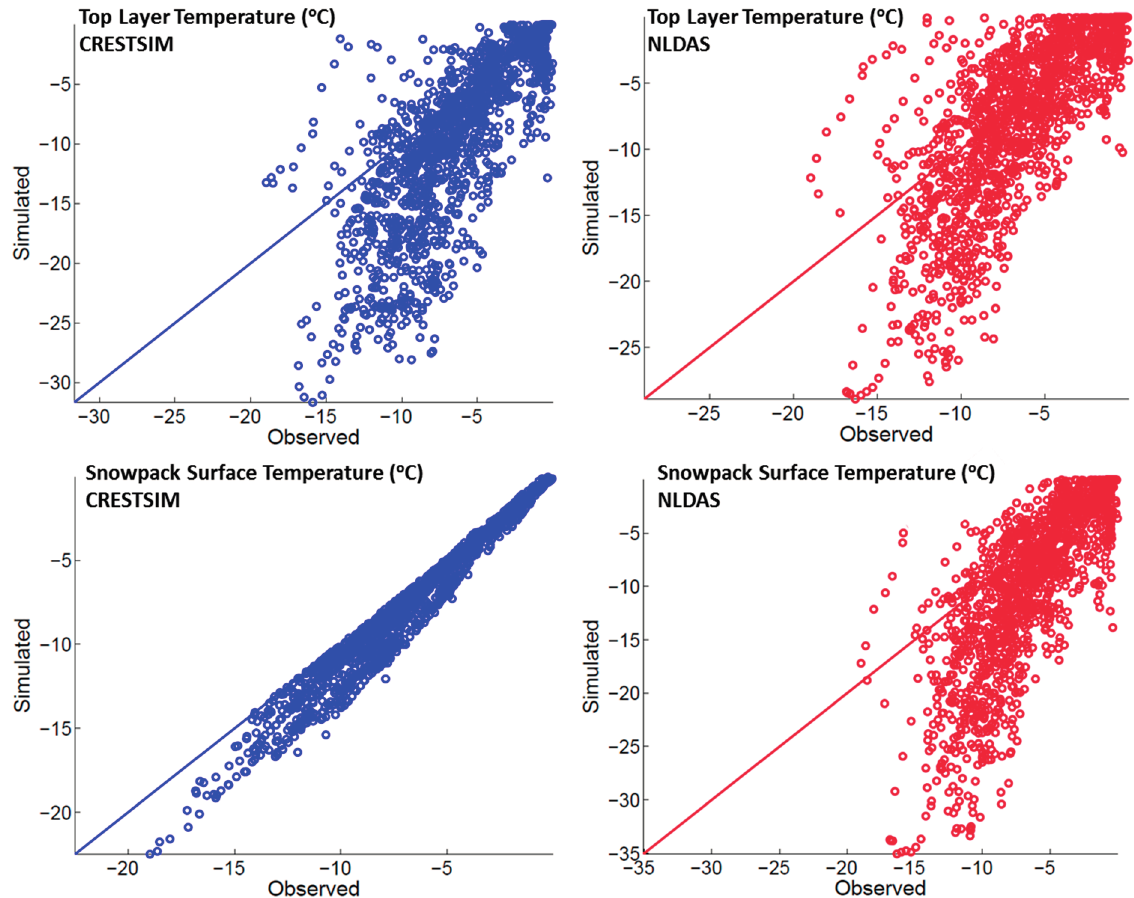
Figure 11. Scatter plot for top layer snowpack temperature ( top ) and snowpack surface temperature ( bottom ) for both simulated scenarios: ( left ) CRESTSIM and ( right ) NLDAS.